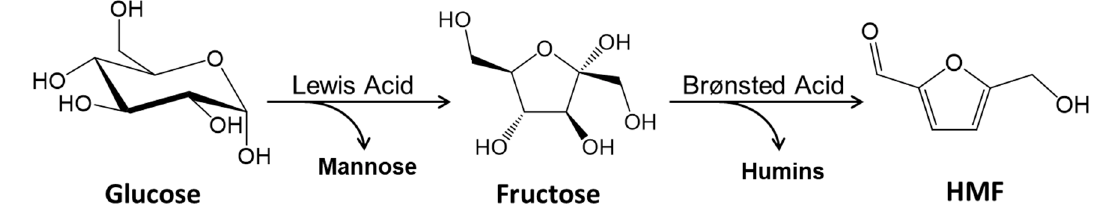
Scheme 1. Simplified reaction scheme for glucose conversion.